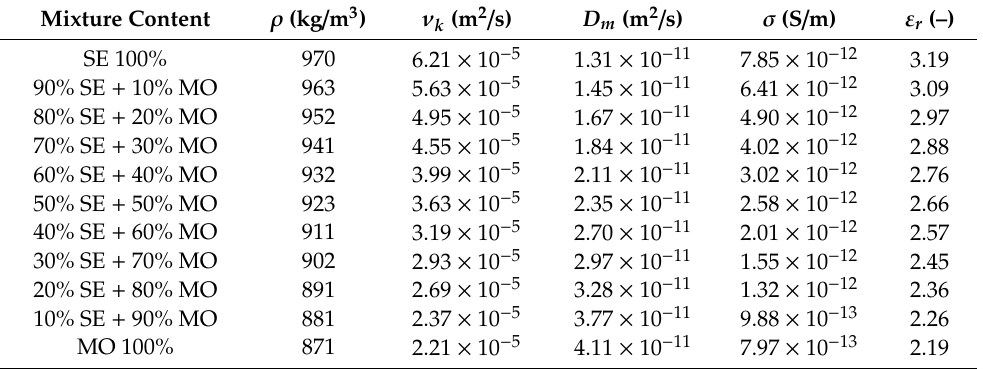
Table 1. Properties of Nycodiel 1255 synthetic ester and fresh Trafo EN mineral oil mixtures (20 ◦ C). Mixture